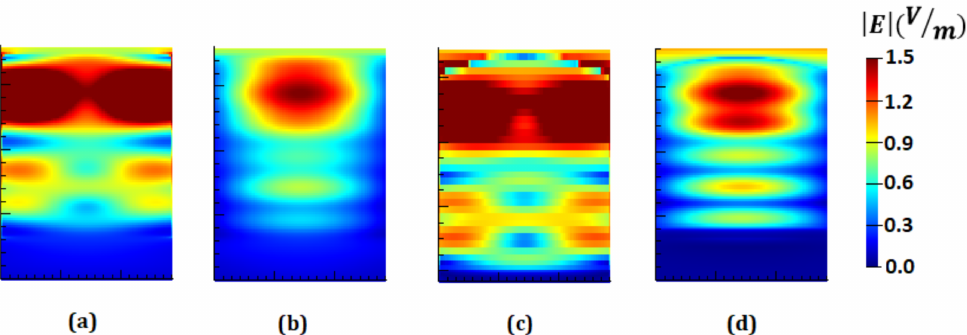
Figure 5. The electric field profile for transverse magnetic (TM) and transverse electric (TE) modes respectively for ( a , b ) the bare InP NW array solar cell, and ( c , d ) the proposed InP NW array solar